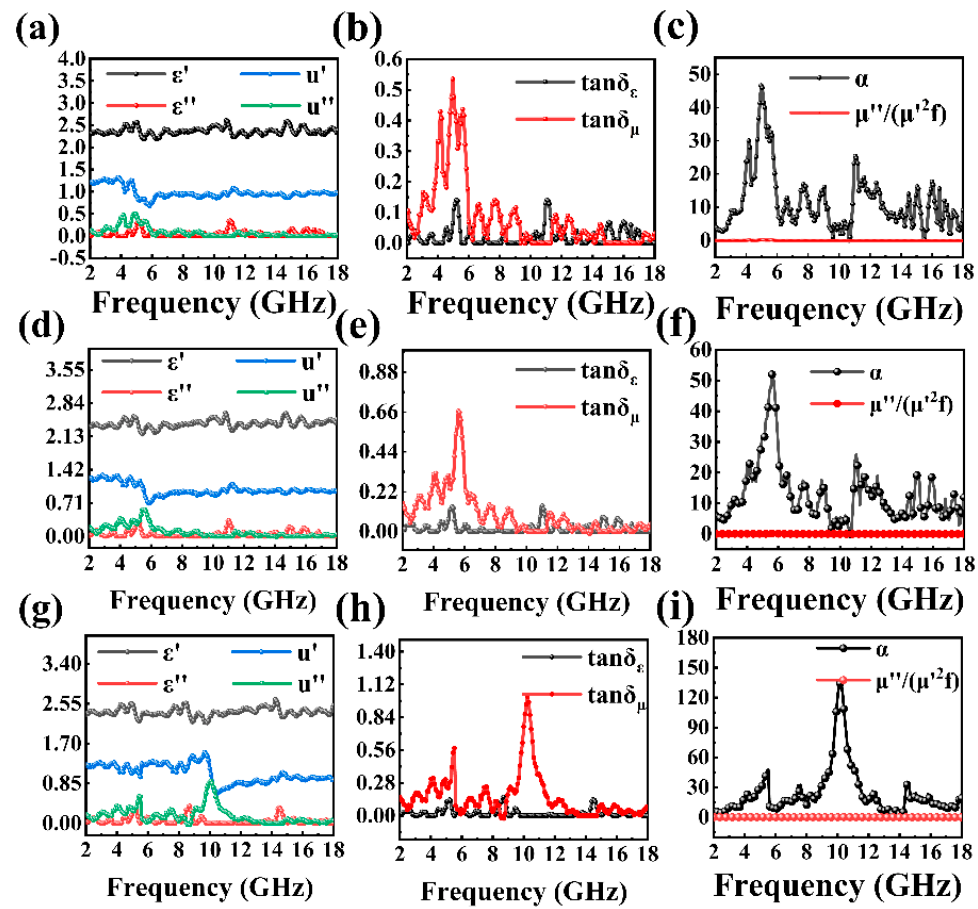
Figure 3. Relevant EM parameters of MnO 2 @D; ( a − c ) FeOOH@D; ( d − f ) and α− Fe 2 O 3 @D; ( g − i ). Frequency dependence of ε′ , ε′′ , μ′ and μ′′ ( a , d , g ); dielectric and loss tangent ( b , e , h ); attenuation constant α and μ′′ ( μ′ ) − 2 f − 1 values ( c , f , i ). Due to the dielectric loss tangent ( ε (cid:48)(cid:48) / ε (cid:48) ) and magnetic loss tangent ( µ (cid:48)(cid:48) / µ (cid:48) ) value The calculation formula of RL [47,48]: the dielectric loss angle tangent and magnetic loss angle tangent of the three samples